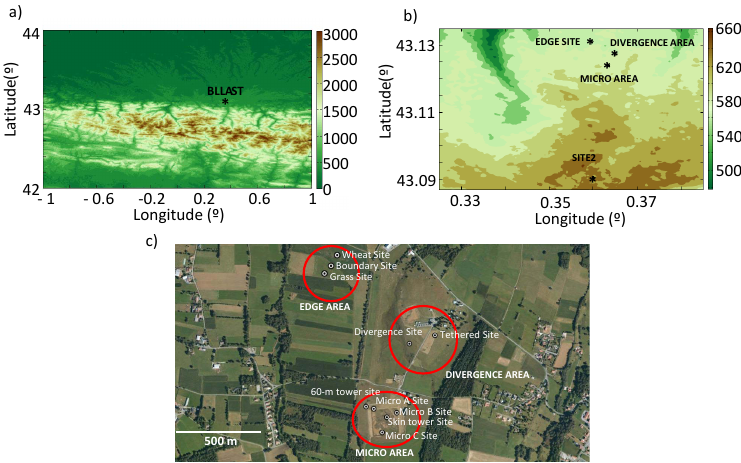
Figure 1. (a) Topographic map of Pyrenees area around BLLAST. (b) Topographic map of BLLAST area. (c) Aerial view of BLLAST sites (except area 2). NOTE – panels (a) and (b) from Routine ASTER Global Digital Elevation Model from NASA Land Processes Distributed Active Archive Center (LP DAAC). Panel (c) from Google Earth. Table 1. Characteristics of BLLAST sites considered in this